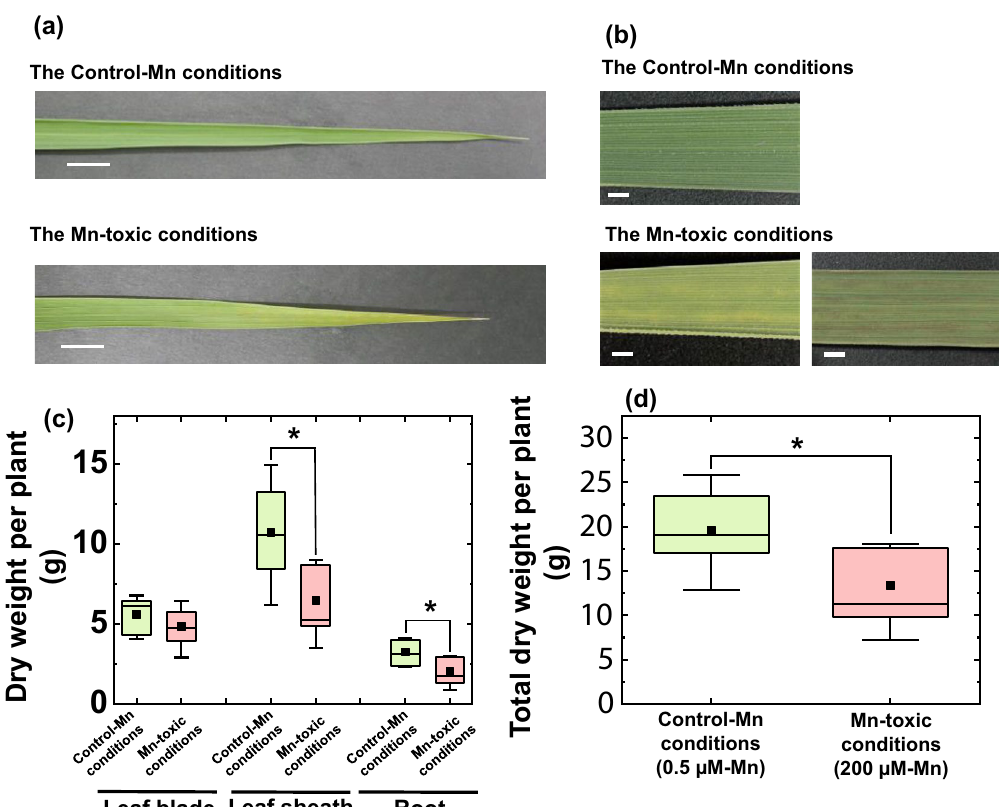
Figure 1. Phenotypes of rice plants grown under control and Mn-toxic conditions. The pictures of fully expanded leaf blades grown under control and Mn-toxic conditions are shown in ( a ), and ( b ) shows an enlarged picture of these. White bars indicate lengths of 1 cm ( a ) and 1 mm ( b ), respectively. ( c ) Dried weights of leaf blade, leaf sheath, and root, respectively. ( d ) The sum of the dried weights is shown in ( c ). Data are shown as box plots obtained by independent biological replicates (n = 9), black squares indicate the mean value, and bars indicate the range of the maximum or minimum data within a 1.5 × interquartile range (IQR). The green boxes indicate the results of the control conditions, and the red boxes indicate those of the Mn-toxic conditions. Asterisks show significant differences between the control and Mn-toxic conditions (* p < 0.05, Kruskal–Wallis